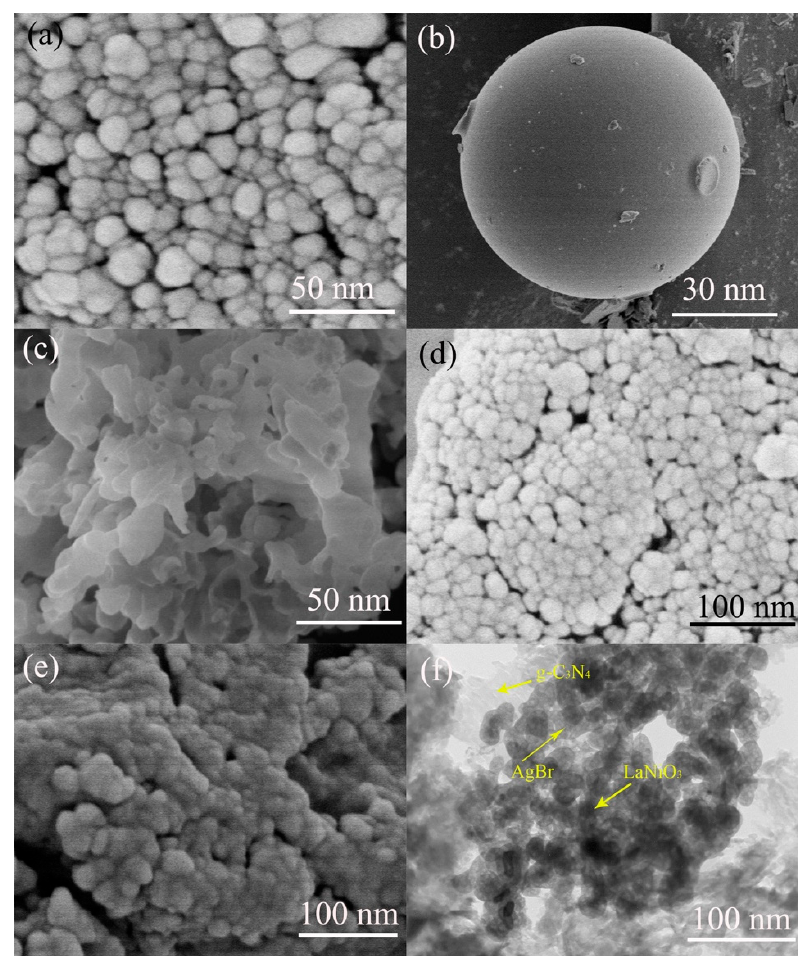
Figure 4. The SEM images of ( a ) AgBr, ( b ) LaNiO 3 , ( c ) g-C 3 N 4 , ( d ) LG, ( e ) 3-ALG and TEM image of 3-ALG ( f ).